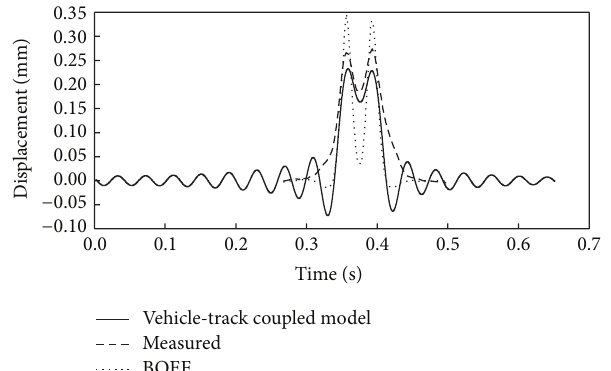
Figure 5: Comparison of the measured sleeper displacement with that obtained from the vehicle-track coupled model and the BOEF model for a single